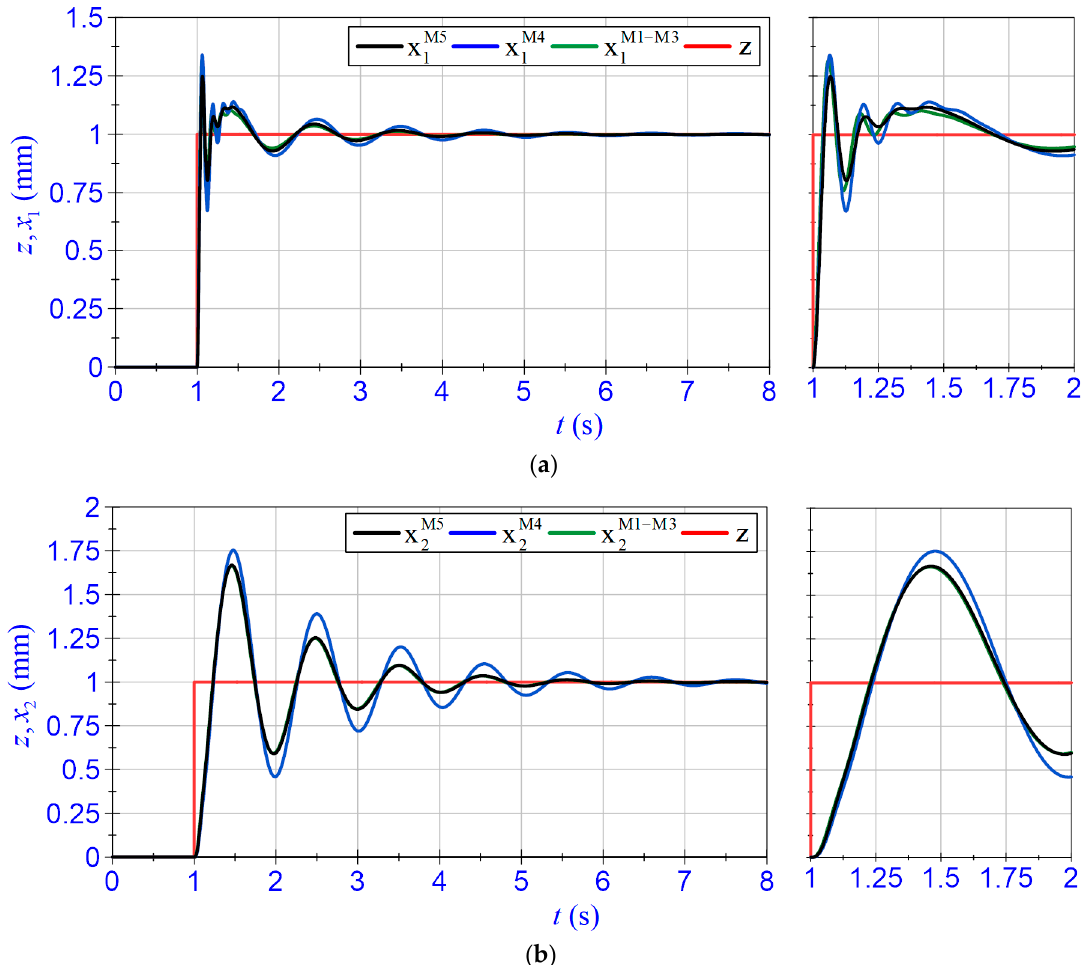
Figure 4. Time patterns: ( a ) displacement z and x 1 ; ( b ) displacement z and x 2